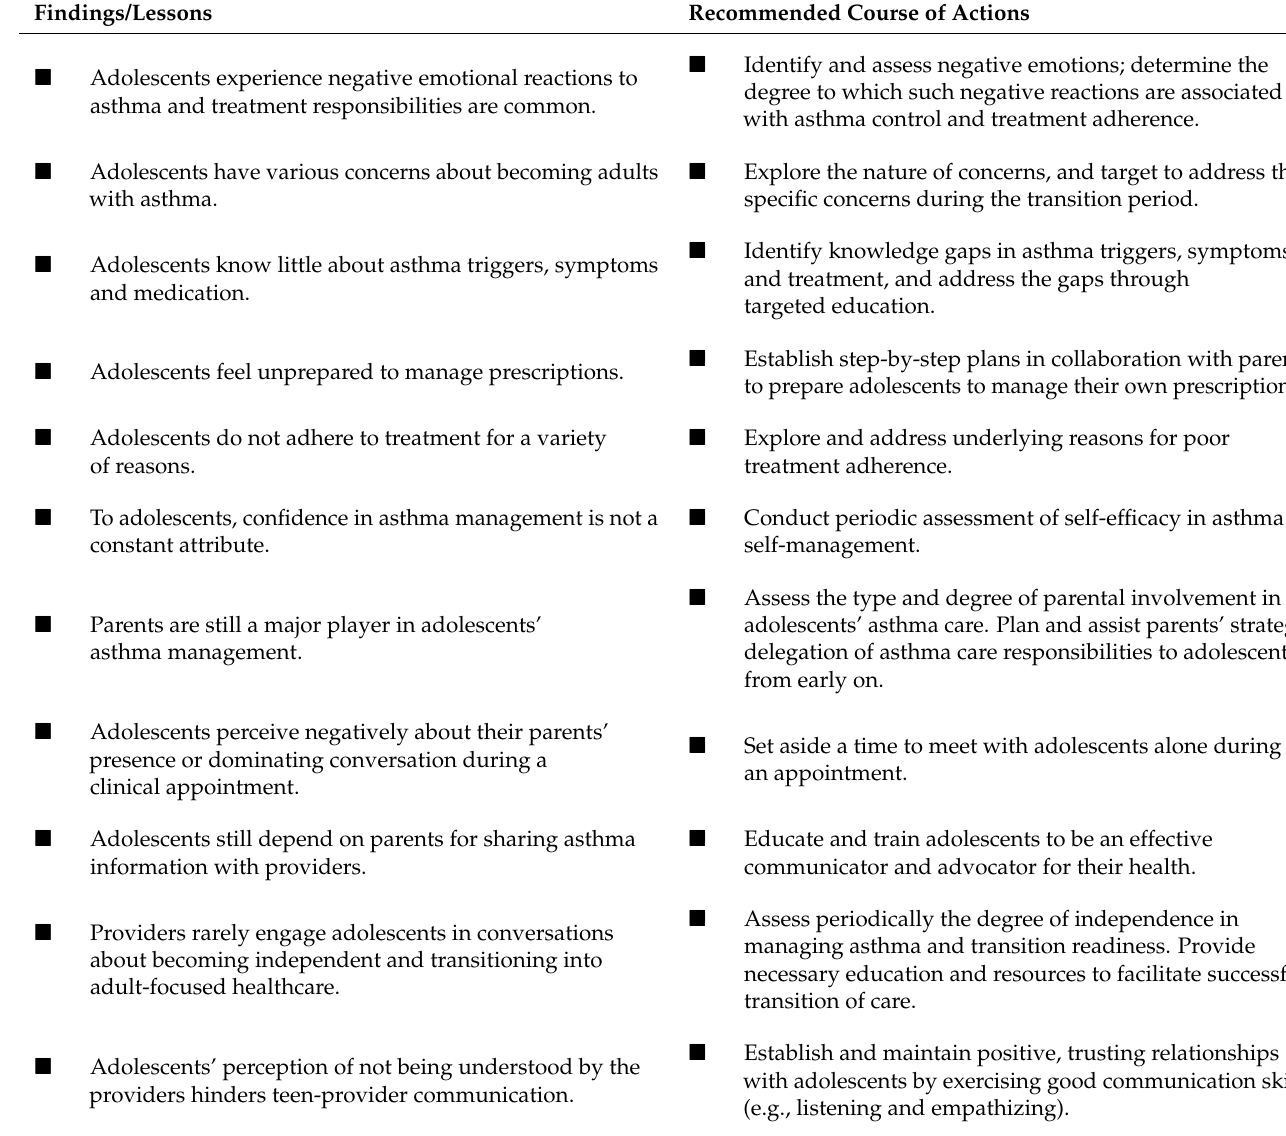
Table 3. Lessons learned and recommendations for clinical practice.